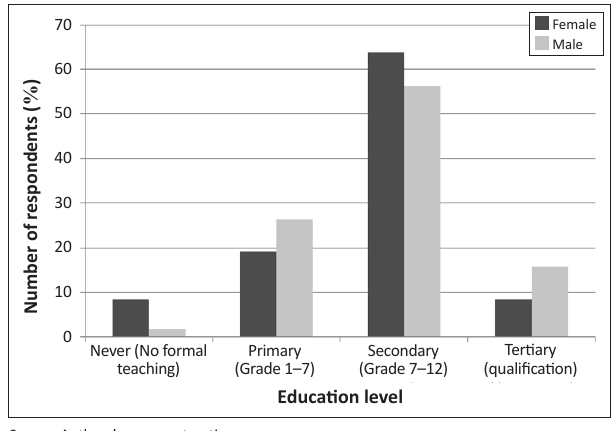
FIGURE 3: Educational level of male and female